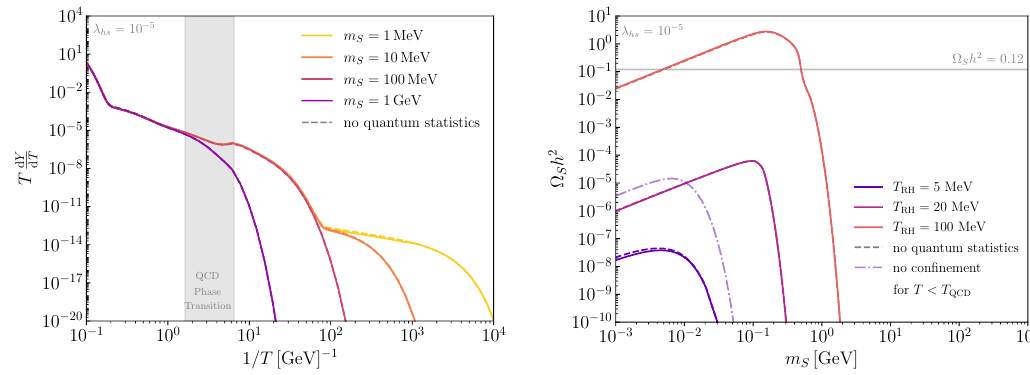
Figure 6 . Left: rate of change of the scalar singlet yield as a function of inverse temperature for λ hs = 10 − 5 and different values of the singlet mass as indicated. The description as an effective dimension-5 operator is valid for T & 5 GeV, while the increase of the rate for smaller temperatures is caused by the resonance (cf. the right panel of figure 4). Right: resulting relic density when integrating the differential yield over T < T RH as a function of the singlet mass and for different values of the reheating temperature. In both panels dashed lines indicate the (small) effect from neglecting quantum statistics. For comparison, the dash-dotted line ignores confinement, but in- cludes quantum statistics